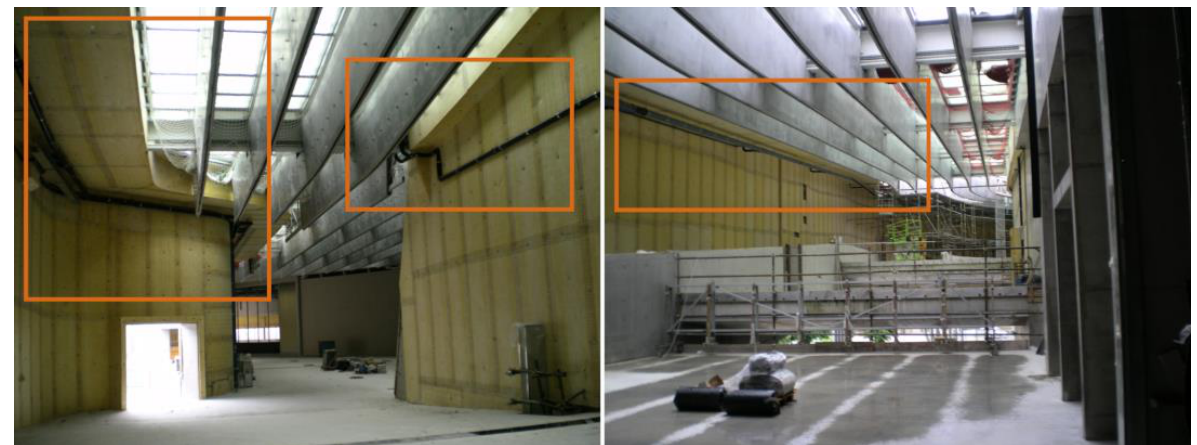
Figure 12. MAXXI, Rome (2010). Construction pictures highlighting the drainage system running inside of the museum (ph. Cardellicchio, 2009).